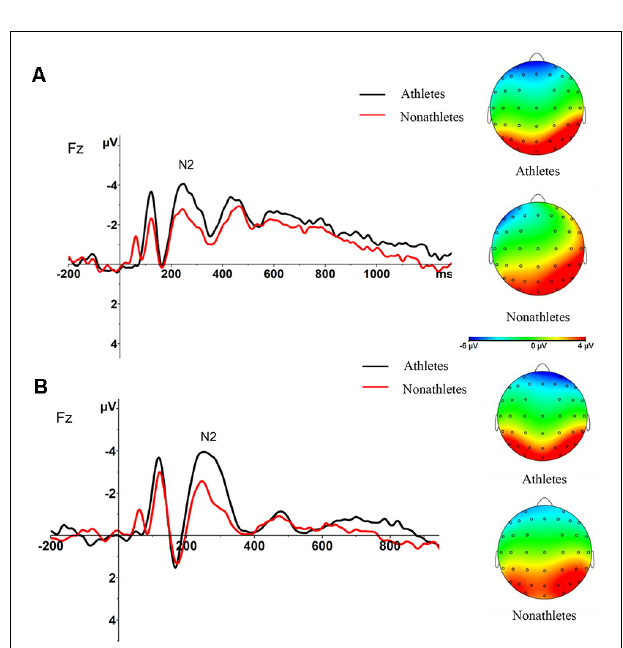
FIGURE 4 | Peak amplitude of N2 and spatial distribution over all electrode at Fz in OT (A) and ET (B) condition per group (M ± SE).